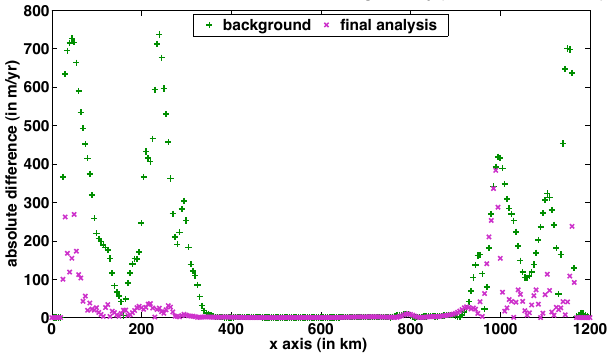
Fig. 16. Bedrock topography after 20 years of the LETKF with in- flation. The background (green) is compared to the reference (blue) and the analyses for various ensemble sizes: 100 members (purple), 50 members (cyan) and 30 members (orange). RMS error evolution is synthesised in Table 3. See also Fig. 17 for detailed